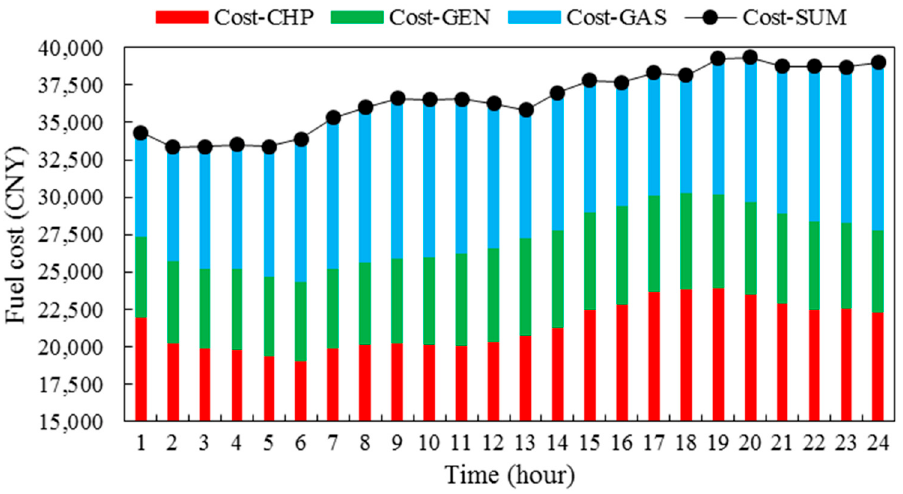
Figure 11. Fuel cost of day-ahead optimal operation for IES.